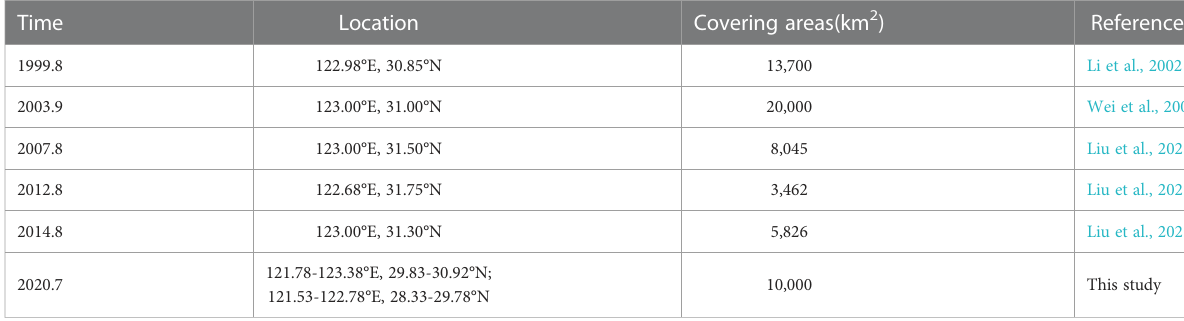
TABLE 3 Historical records of hypoxia and covered area in the East China